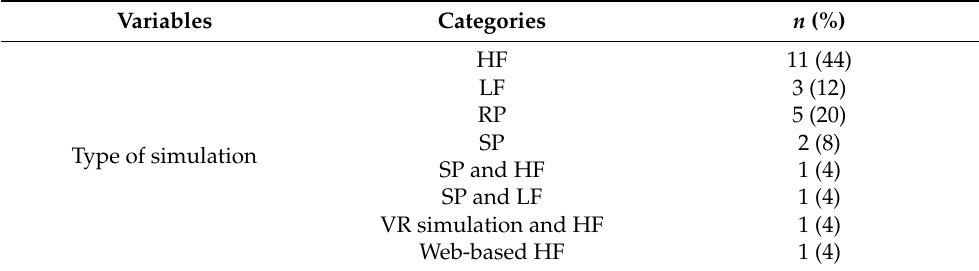
Table 3. Analysis results related to simulation relational variables of studies ( n = 25).